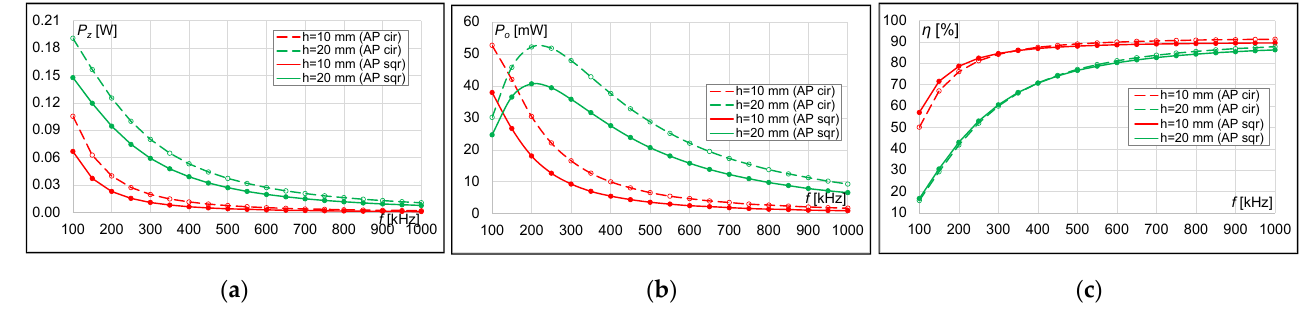
Figure 27. Results for the aperiodic system with circular or square coils with r = 20 mm and the number of turns n = 40 at two distances ( h = 10 mm and h = 20 mm): ( a ) transmitter power, ( b ) receiver power, ( c ) power transfer efficiency.